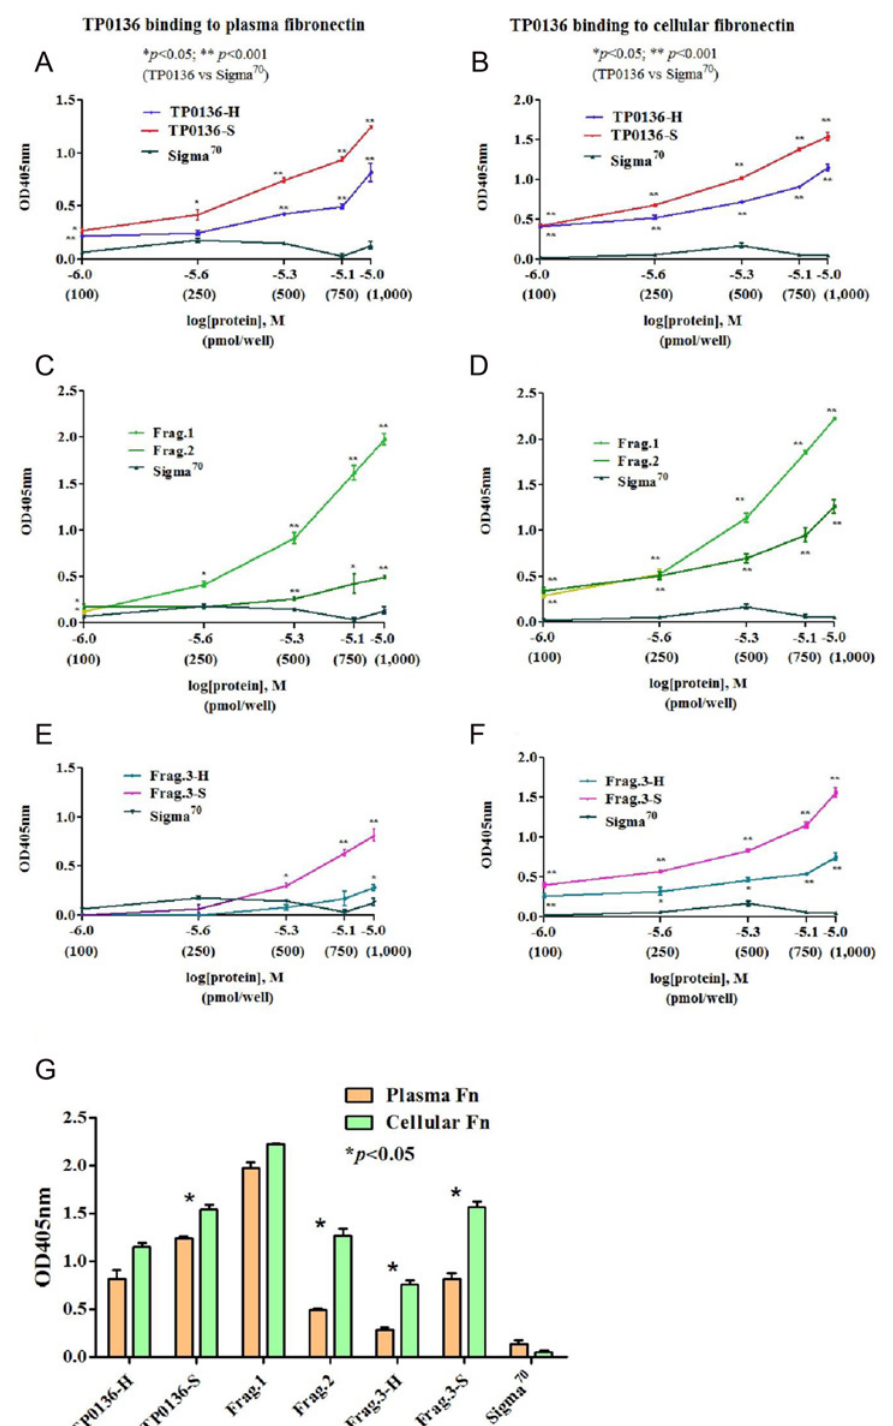
Fig 3. Recombinant TP0136 binding to plasma and cellular fibronectin. Adhesion to plasma and cellular Fn of TP0136 variants was evaluated using full-length recombinant TP0136 (w/o signal peptide) from Nichols Houston and Nichols Seattle, as well as four additional recombinant proteins representing the NH 2 -terminal (Frag.1), central (Frag.2), and COOH-terminal regions (Frag.3-H and Frag.3-S) of both TP0136 variants. T . pallidum transcription factor σ 70 served as negative control. Each experiment was repeated three times to